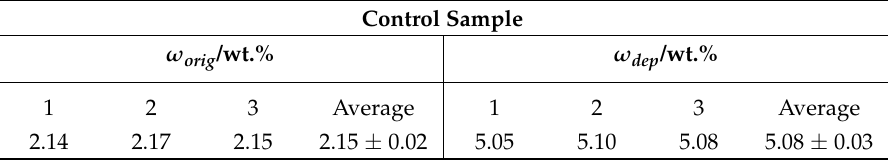
Table 1. Al content comparison of non-bonded powder ( − 30 kV).